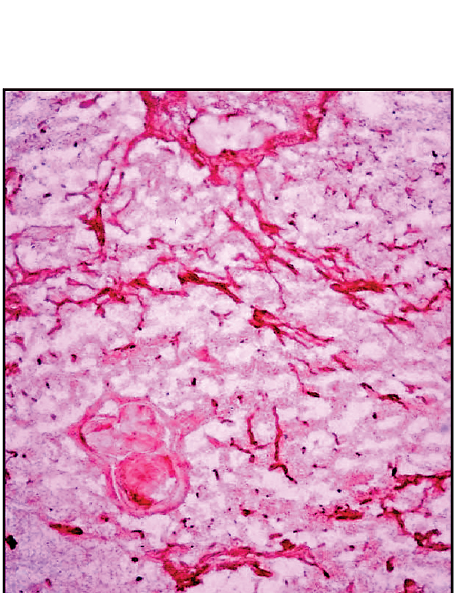
Figure 9. Distribution of matrix metalloproteinase-9 (MMP-9) in the human thymus. In this histo- logical section, MMP-9 distribu- tion is seen in the medullary re- gion of a thymic lobule and sur- rounding blood vessels, similar to the pattern of laminin or fibro- nectin. Original magnification: